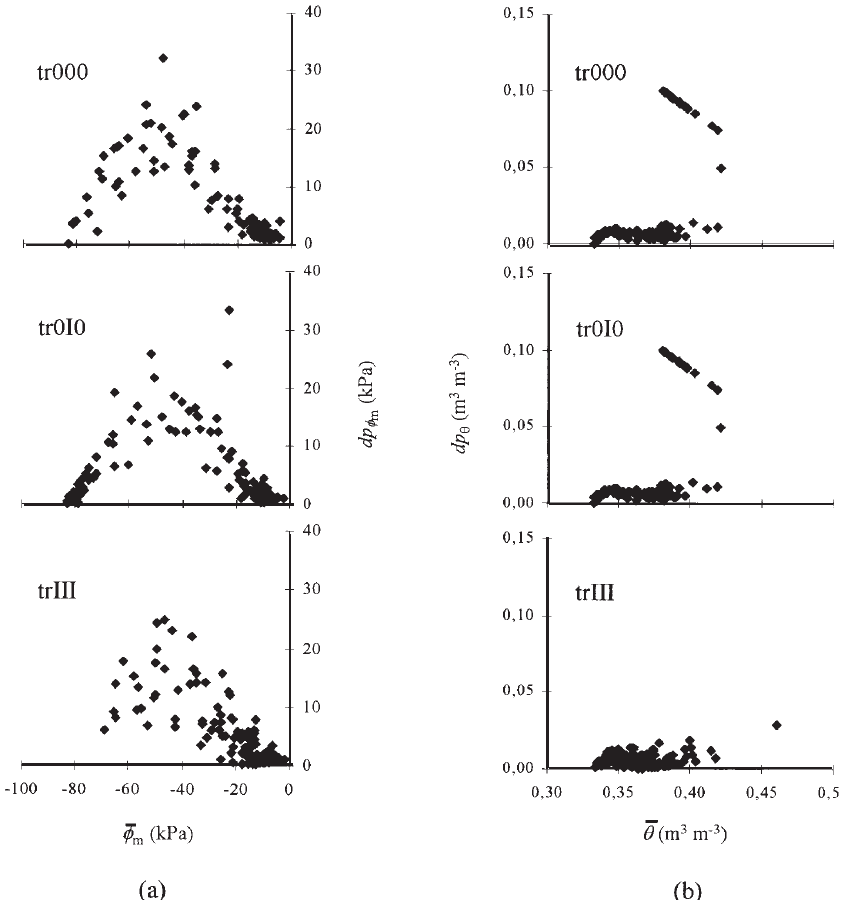
Figura 4. Variabilidade, expressa em termos de desvio-padrão : (a) do potencial mátrico ( dp umidade do solo (dp qq qq q ), para profundidade de 0,20